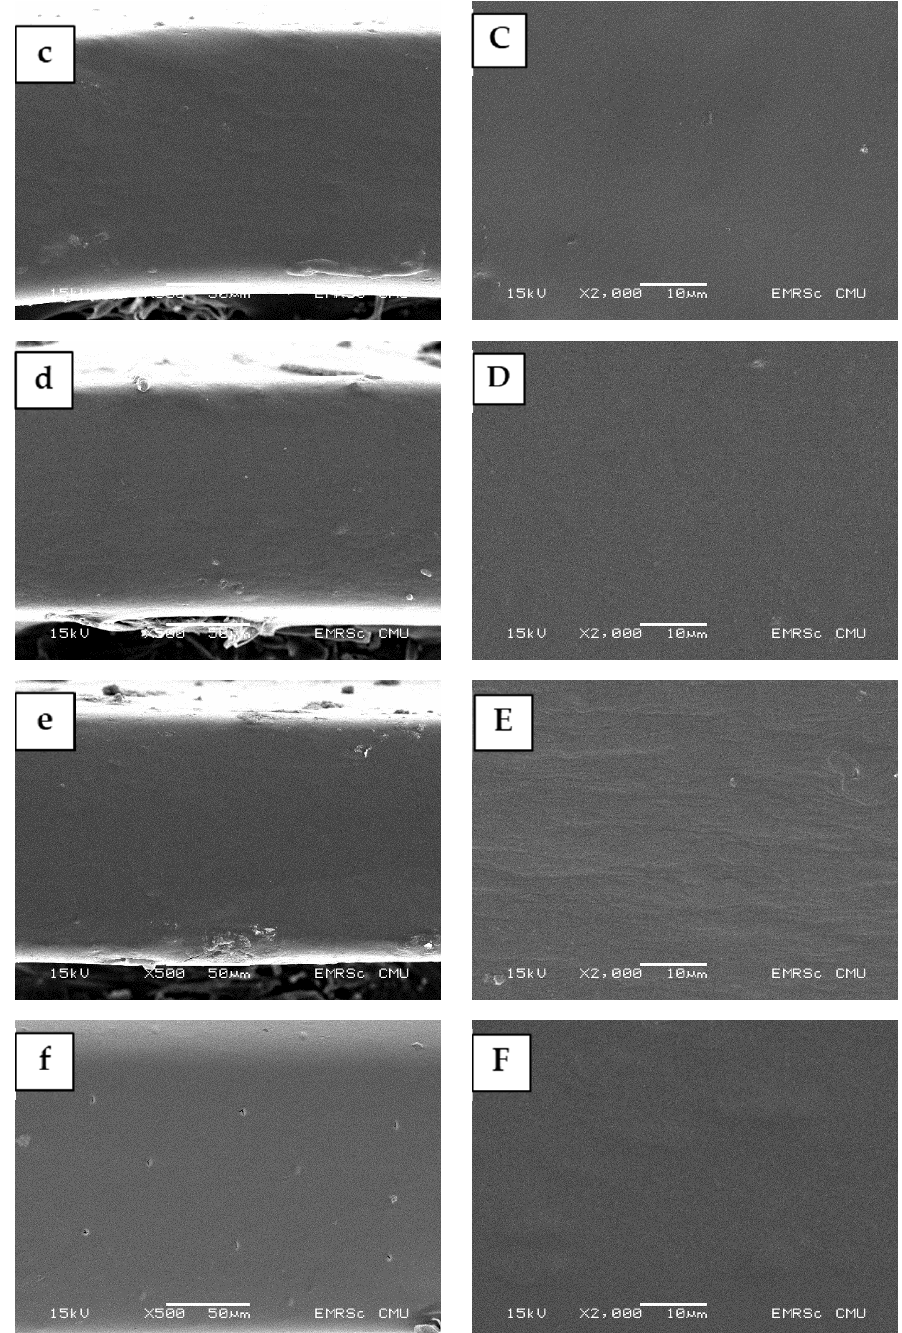
Figure 3. The SEM micrographs of ( a ) rice starch film, and CMSr film synthesized with ( b ) 10%, ( c ) 20%, ( d ) 30%, ( e ) 40%, and ( f ) 50% NaOH concentrations at 1000× followed by the cross-section micrographs of ( A ) rice starch film, and CMSr film synthesized with ( B ) 10%, ( C ) 20%, ( D ) 30%, ( E ) 40%, and ( F ) 50% NaOH concentrations at 2000×.